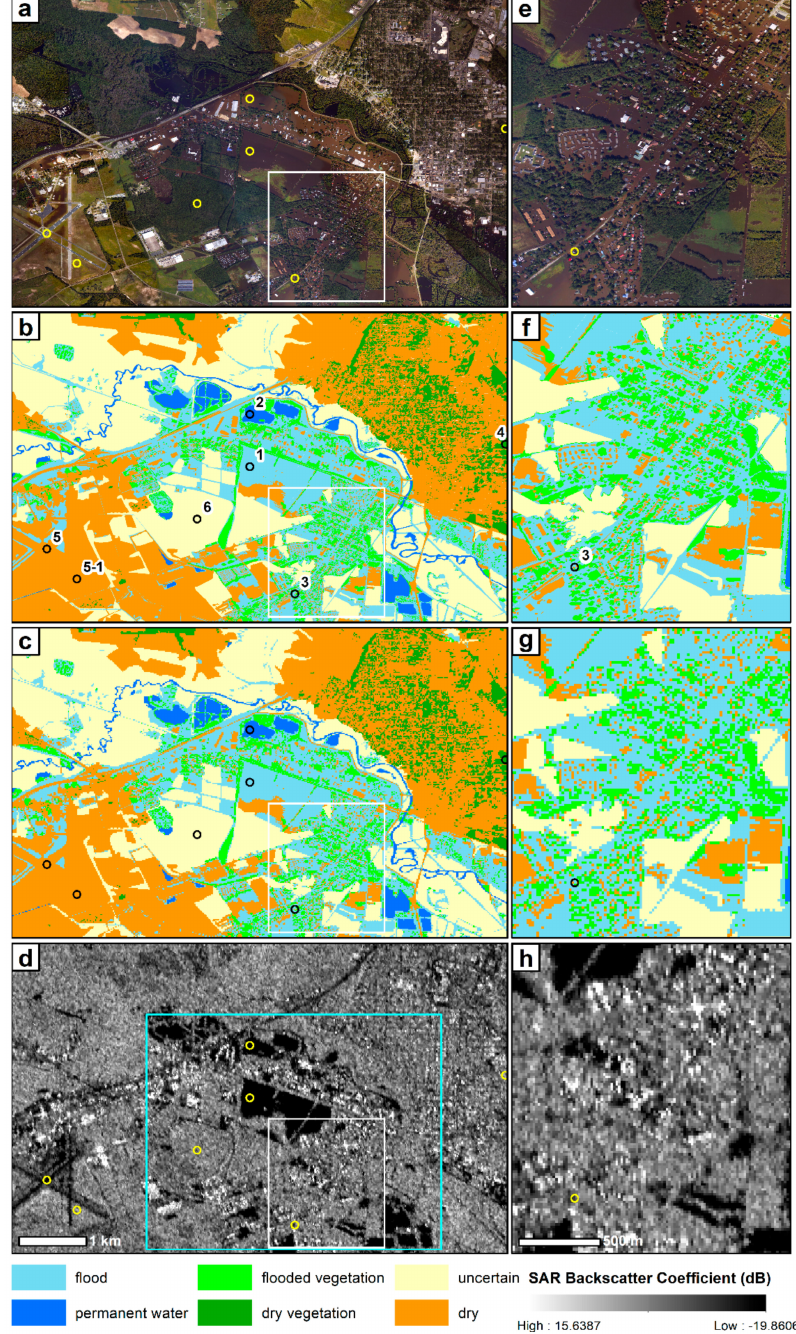
Figure 2. ( a ) The during-event aerial image and ( b ) the validation vector image with 30 cm resolution. ( c ) The rasterized validation image at 15 m resolution. ( d ) The during-event Sentinel-1 synthetic aperture radar (SAR) image at 15 m posting. The cyan box indicates the region used for Gaussian curve fitting. ( e , f ) The magnified views of ( a – d ) for the urban area. The open circles labeled 1 to 6 in ( b ) are the sample pixels of the time series (Figure 4) for each